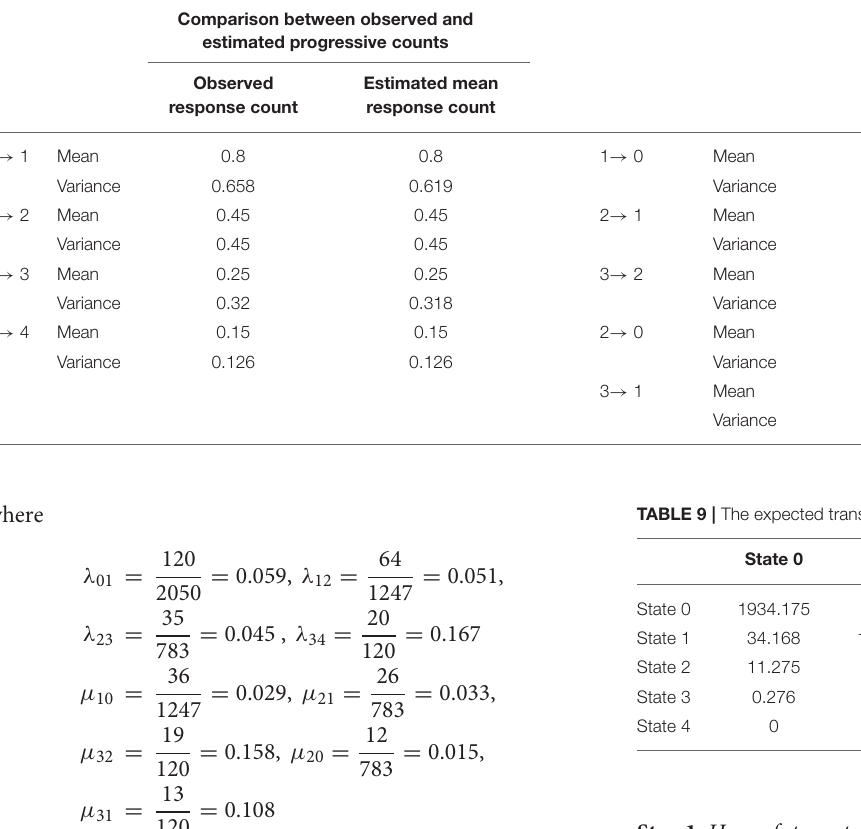
TABLE 8 | The comparison between observed and estimated response rate after fitting Poisson model. Comparison between observed and estimated progressive counts